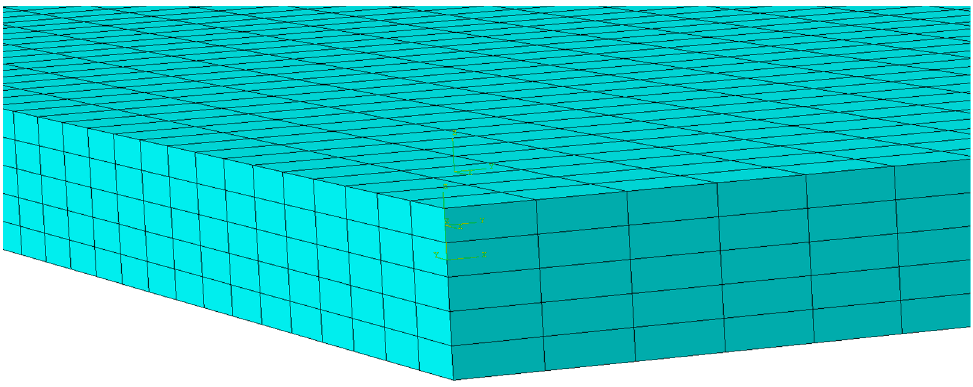
Figure 6. Meshes of FE CLT model.